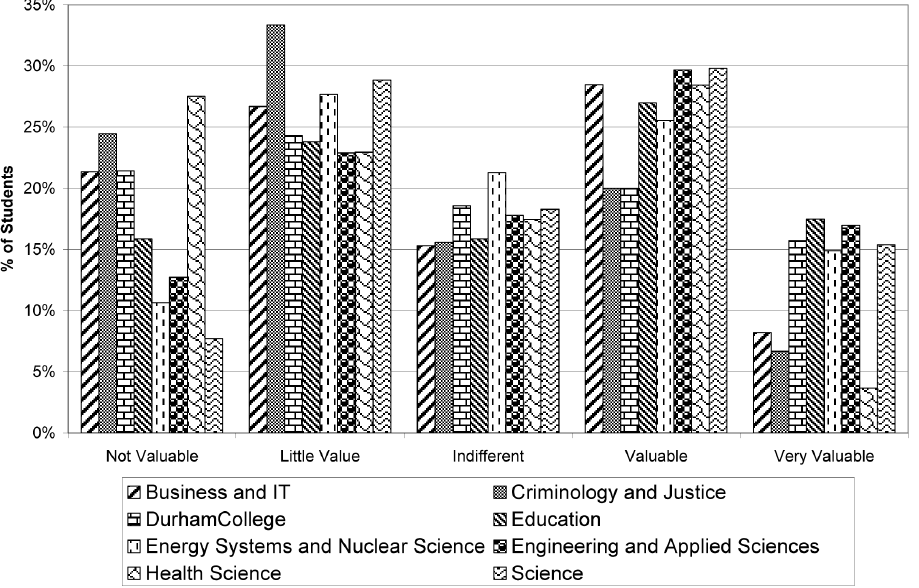
Figure 3. Perceived value of